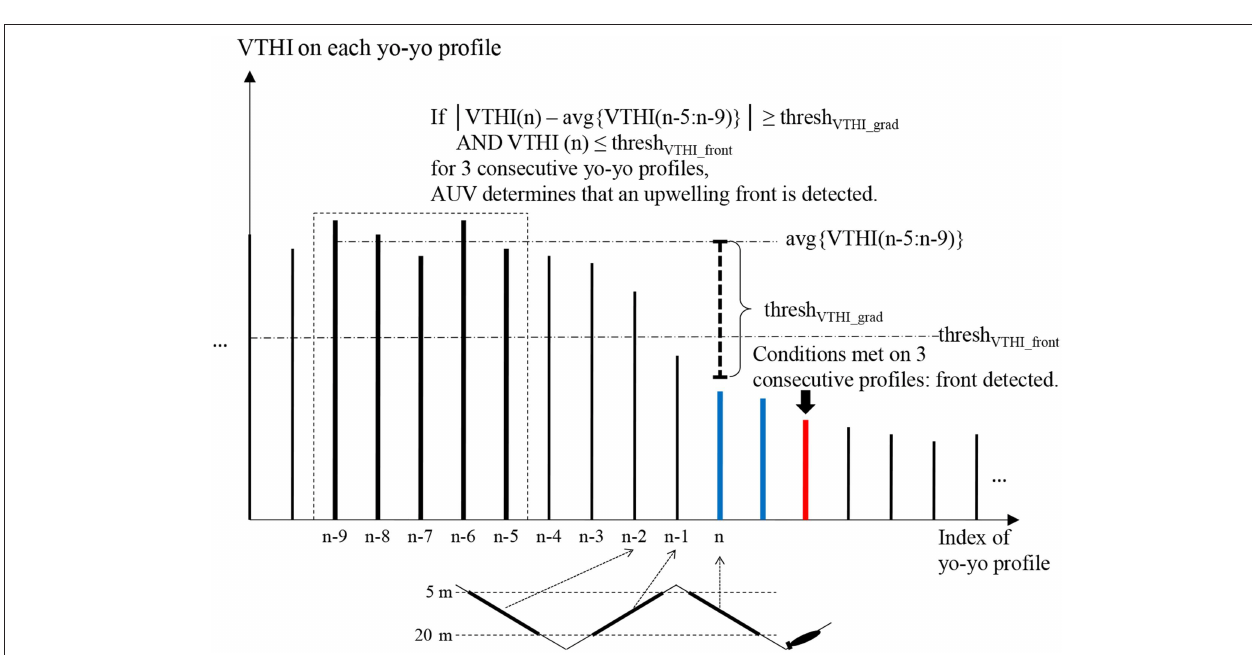
FIGURE 3 | Satellite SST of Monterey Bay during the June 2011 experiment. The line along 36.9 ◦ N (from 121.9 ◦ W to 122.25 ◦ W) marks the Dorado AUV’s 31-km transect. Reused from Zhang et al. (2012c) with permission. Time is in Pacific Daylight Time (PDT).